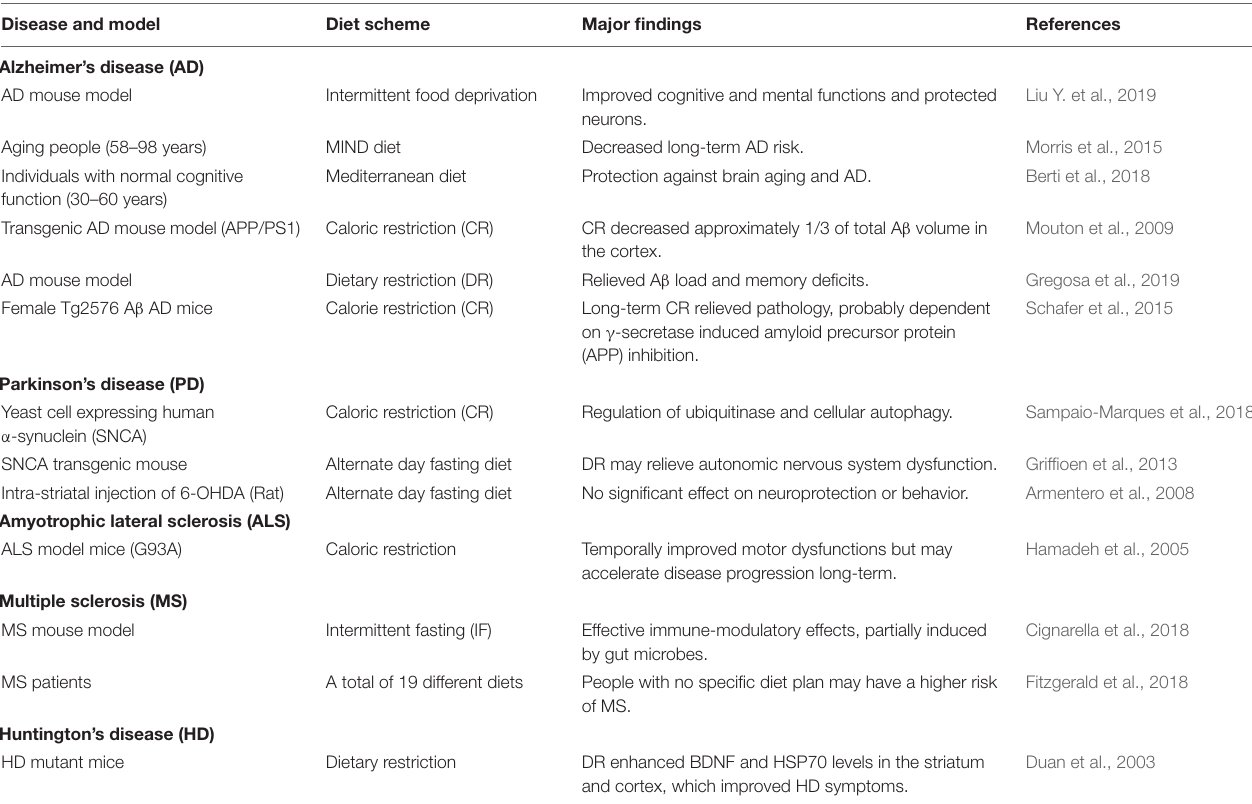
TABLE 2 | Recent studies of dietary interventions for different neurodegenerative